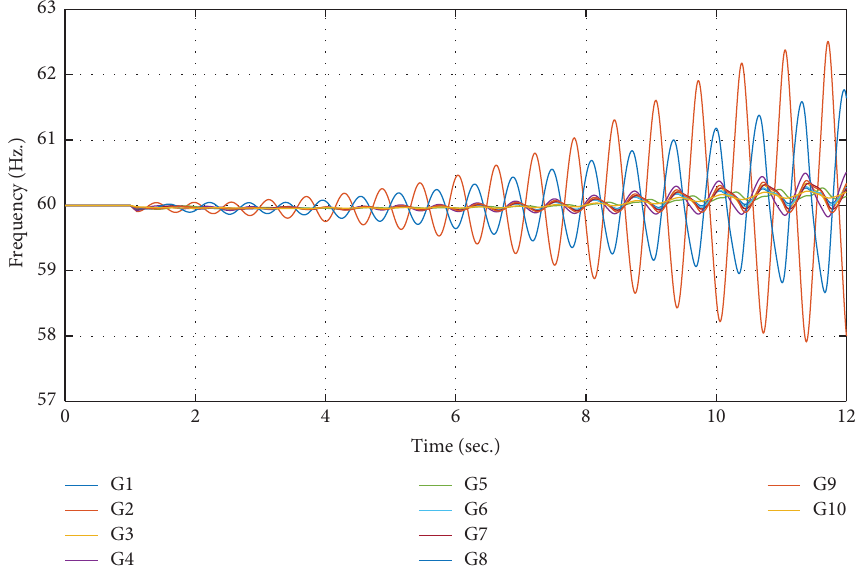
Figure 8: Time-domain simulation of IEEE 39-bus system for conventional